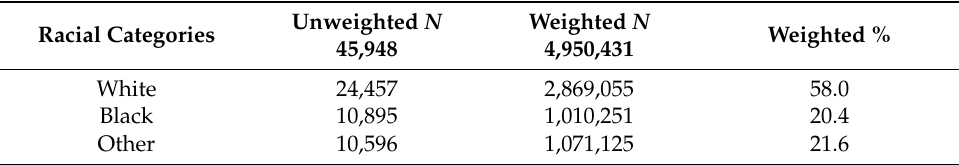
Table 1. AMA hospital stay characteristics by racial